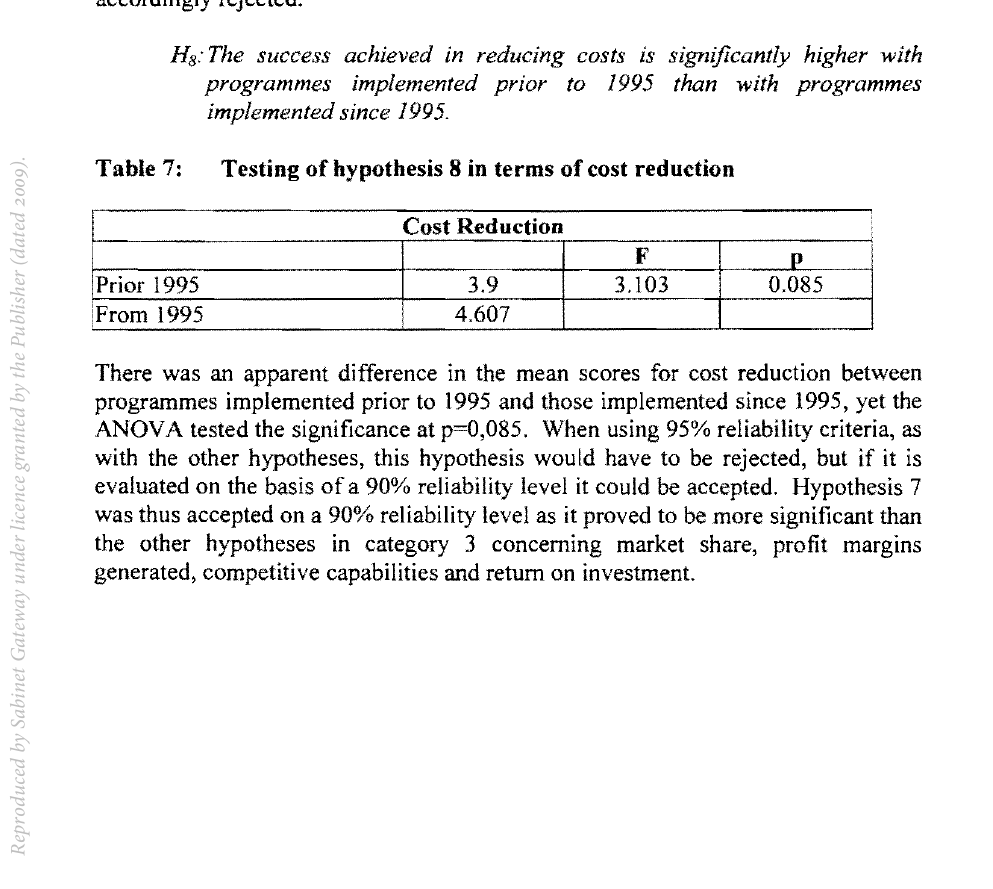
Testing of hypothesis 8 in terms of cost